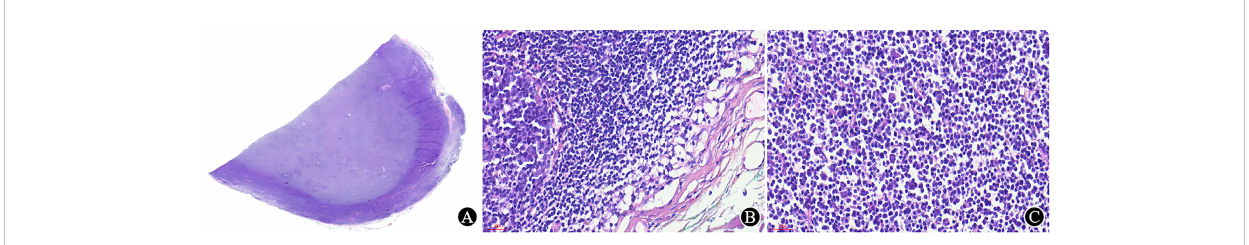
FIGURE 2 Poorly fi xed lymph node. (A) Under low magni fi cation, the lymph nodes is well stained in the periphery and lightly stained in the center (×5.5); (B) The structure near the capsule is well preserved, and the cell morphology is good (×400); (C) The tissue is dissociated, and the cells are shrunken in the area away from the capsule